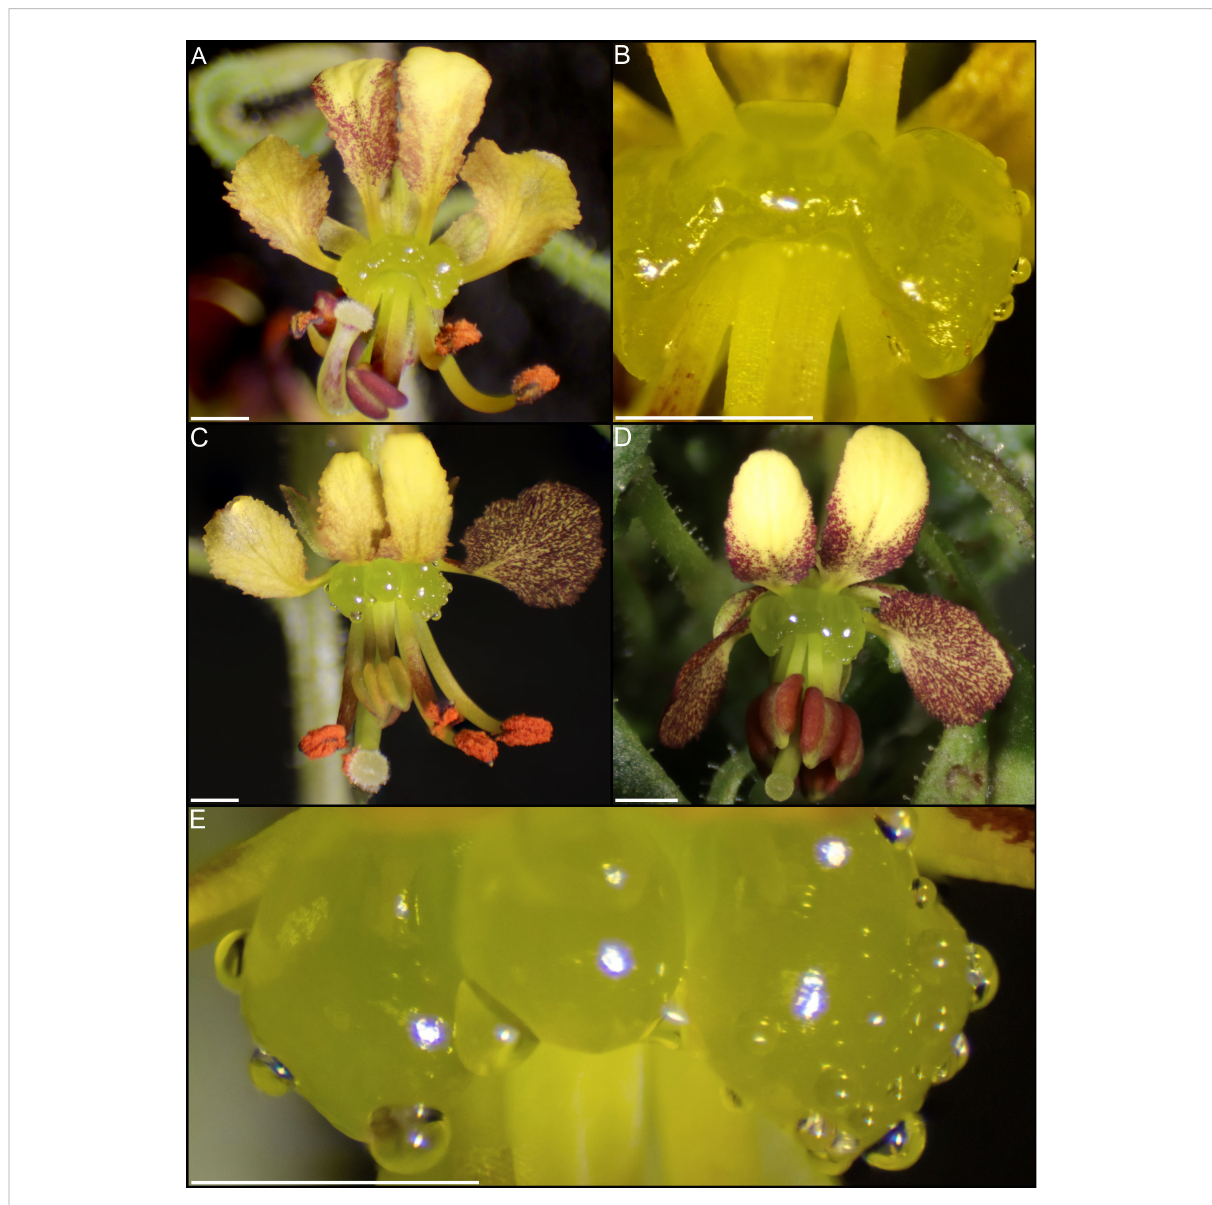
FIGURE 10 Flowers of Cleome violacea treated with pTRV2- CvSWEET9-CvANS constructs. (A) Flower with moderate yellowing and nectary with reduced nectar accumulation. (B) Magni fi ed view of nectary in A. (C) Flower with partial yellowing and partial normal phenotype. (D) Flower with near-normal pigmentation and reduced nectar production. (E) Magni fi ed nectary from C displaying decreased nectar accumulation correlating with yellowing phenotype. Scale bars = 1